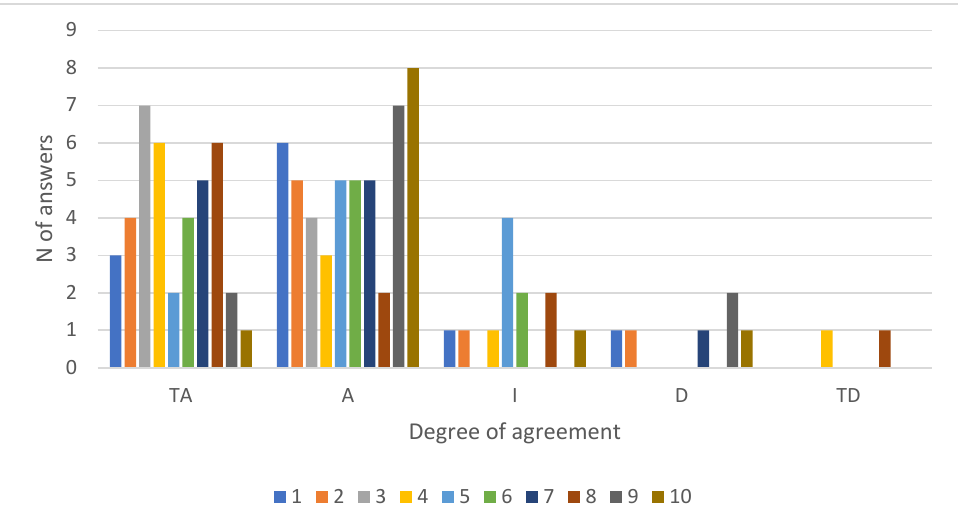
Figure 6. Distribution of answers indicating degrees of agreement with each statement in the user satisfaction questionnaire with musician-specific hearing protection devices ( n = 11).